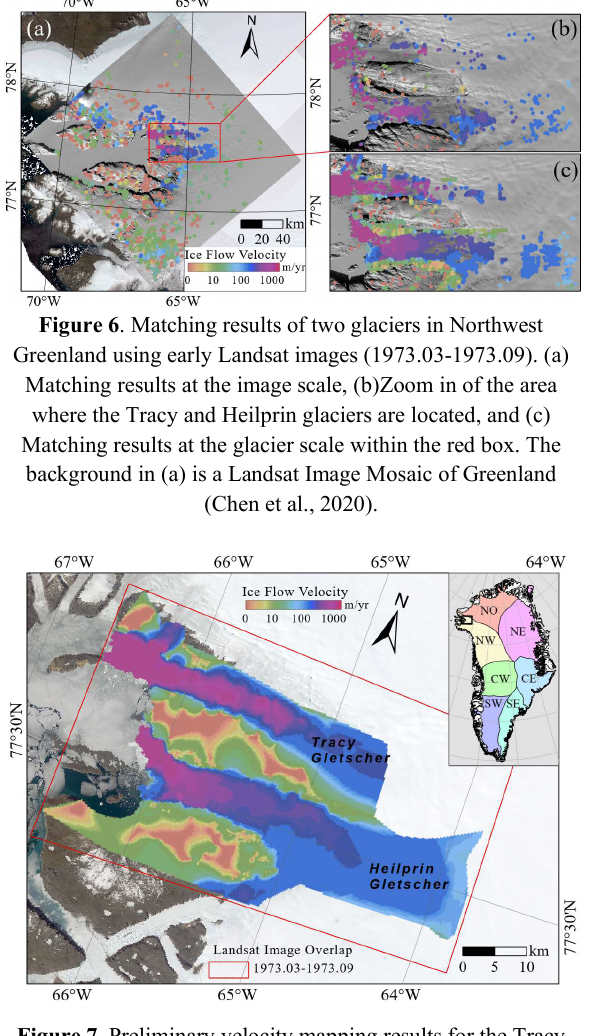
Figure 7 . Preliminary velocity mapping results for the Tracy and Heilprin glaciers in Northwest Greenland using early Landsat images (1973.03-1973.09). The basin boundary is from Mouginot and Rignot (2019). The background is a Landsat Image Mosaic of Greenland (Chen et al.,